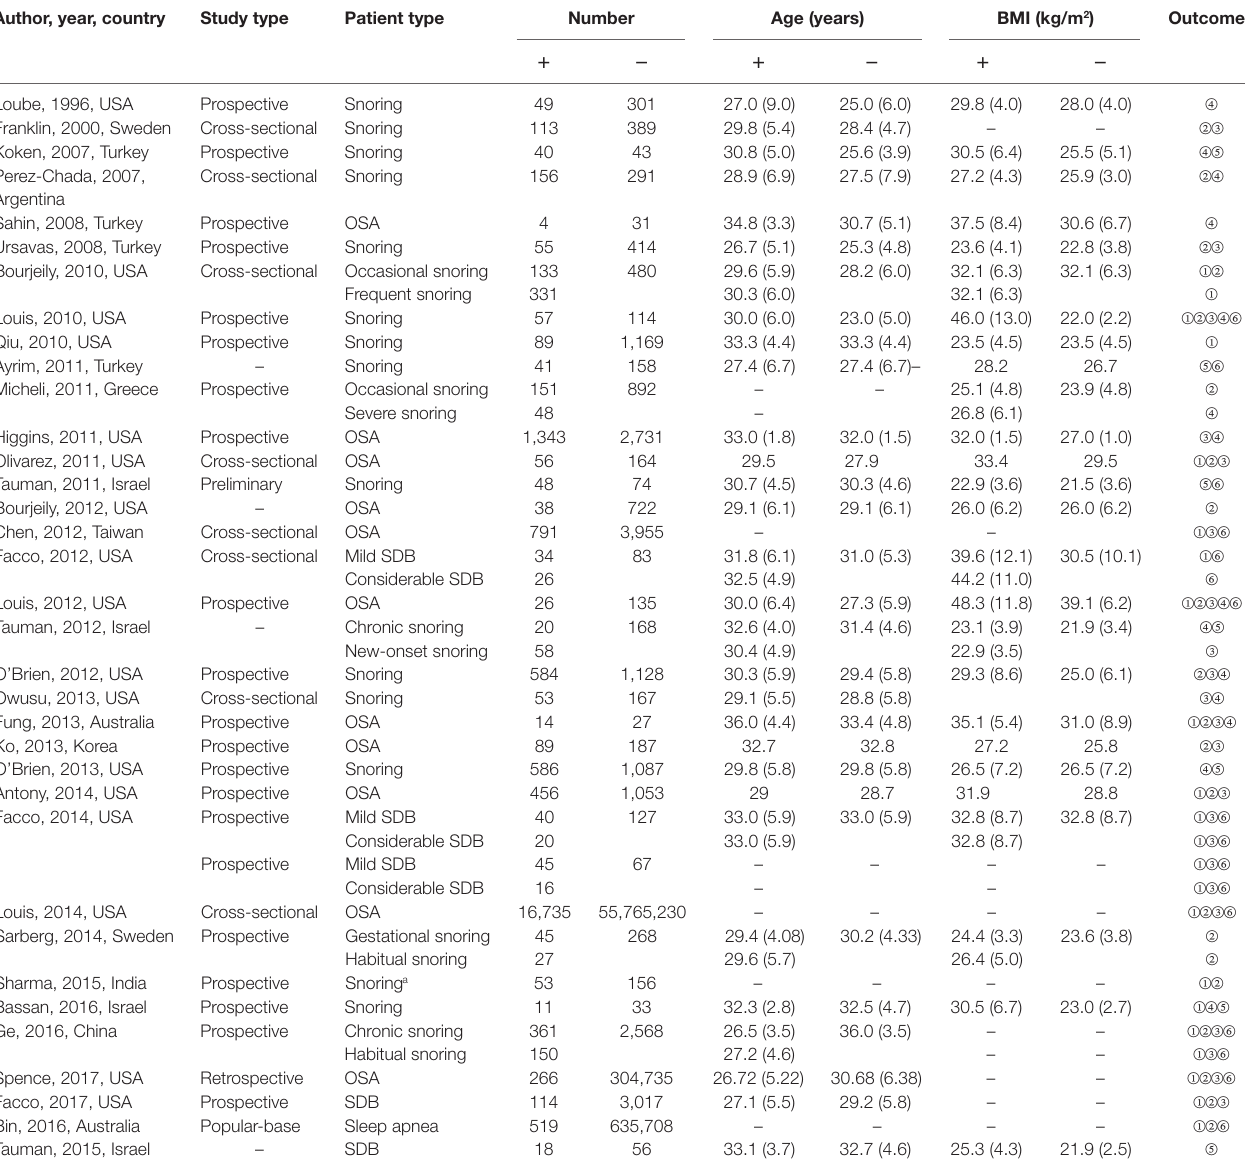
taBLe 1 | Characteristics of Studies Included in